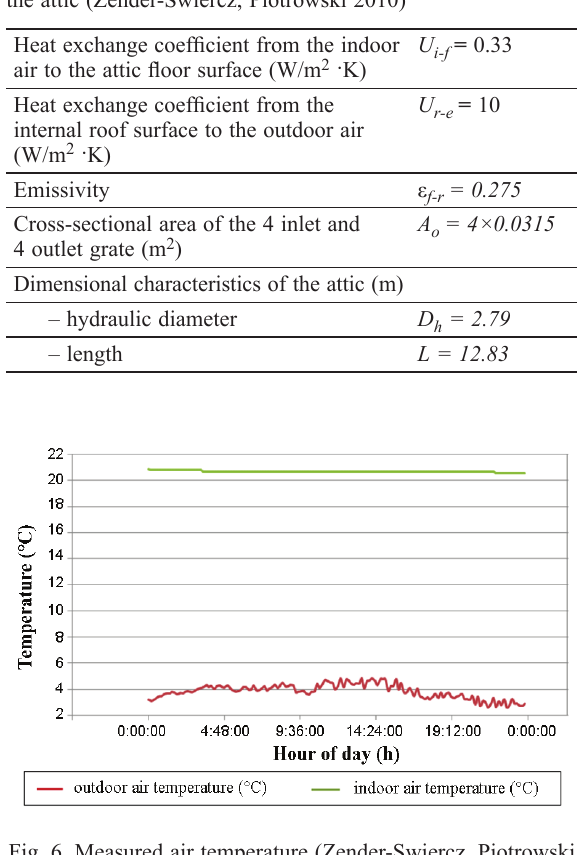
Fig. 6. Measured air temperature (Zender-Swiercz, Piotrowski 2010)